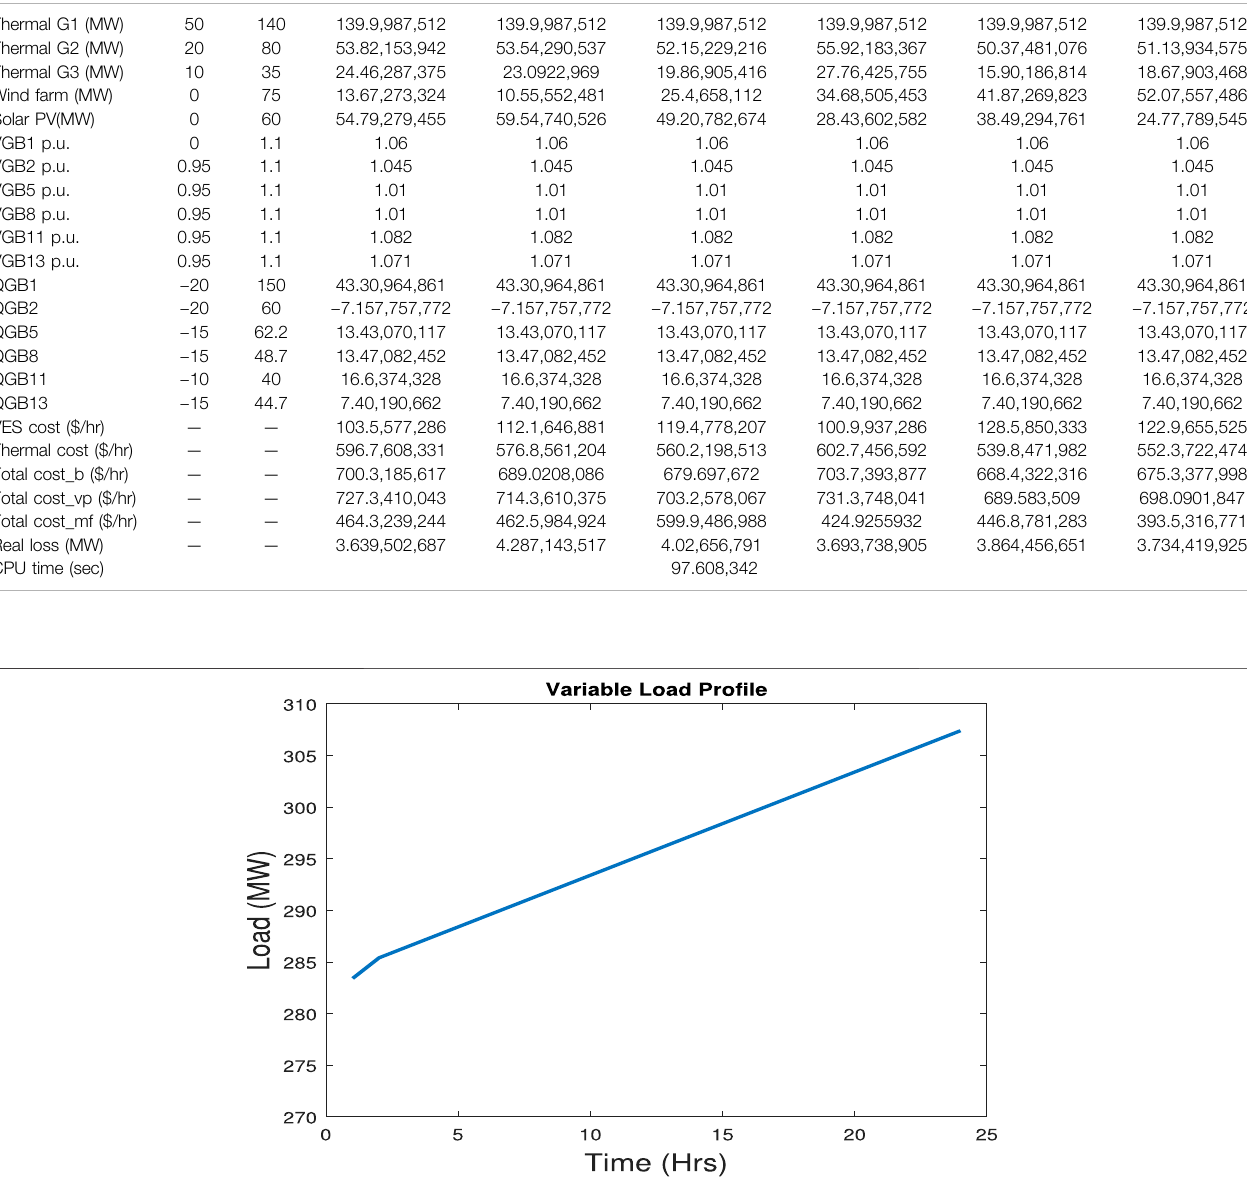
TABLE 9 | Independent variable settings for DA-DOPF. Independent Min. Max. Interval 1 Interval 2 Interval 3 Interval 4 Interval 5 Interval 6 variables Thermal G1 (MW) 50